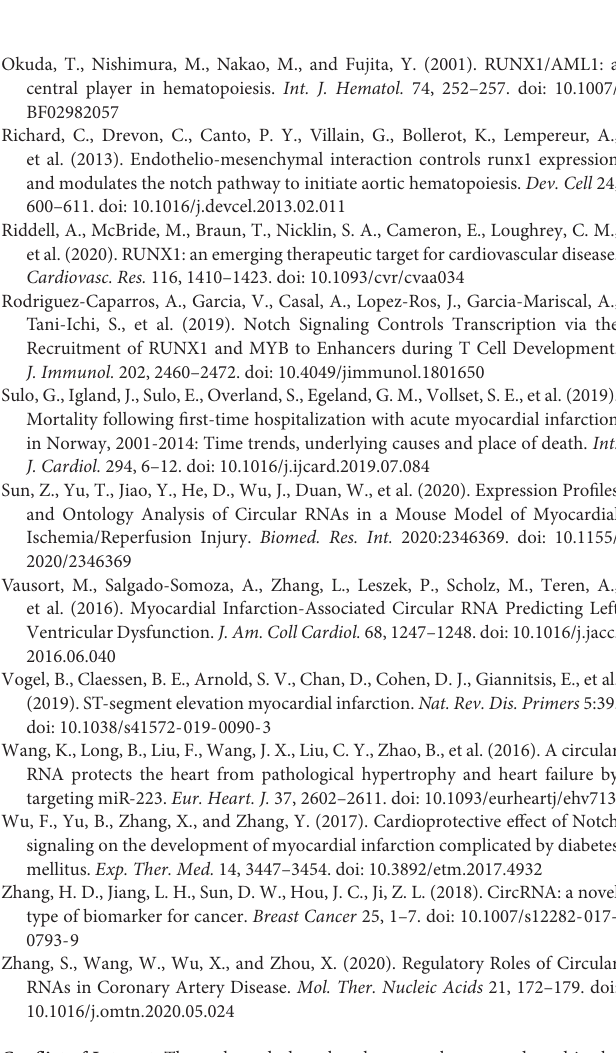
Supplementary Table 1 | Identification of miRNA-circRNA pairs. Differentially expressed circRNAs identified in microarray analysis and dysregulated miRNAs identified in GSE 31568 between AMI and ctrl by application of miRanda; 97 circRNAs have binding sites with